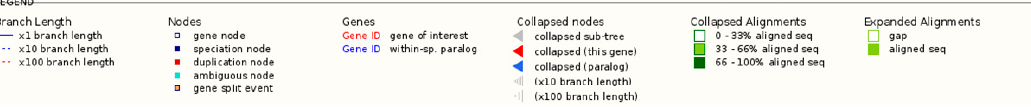
Figure 4. Gene tree for human CYP3A4 , 3A5 , 3A7 , 3A43 , 4A11 , 4A22 , 4B1 , 4F2 , 4F3 , 4F8 , 4F11 , 4F12 , 4F22 , 4V2 , 4X1 , 4Z1 , 5A1/TBXAS1 , and 46A1 built using Ensembl 84. These CYP3 , 4 , 5 and 46 family genes are paralogs to each other derived from the same ancestral gene via duplication events. The gene tree includes a total of 1008 genes from various species. The total number of speciation nodes is 558, and the number of duplication is 384. The number of ambiguous nodes is 31, and there are 4 gene split events.